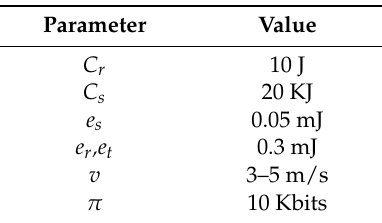
Table 2. Parameter settings.